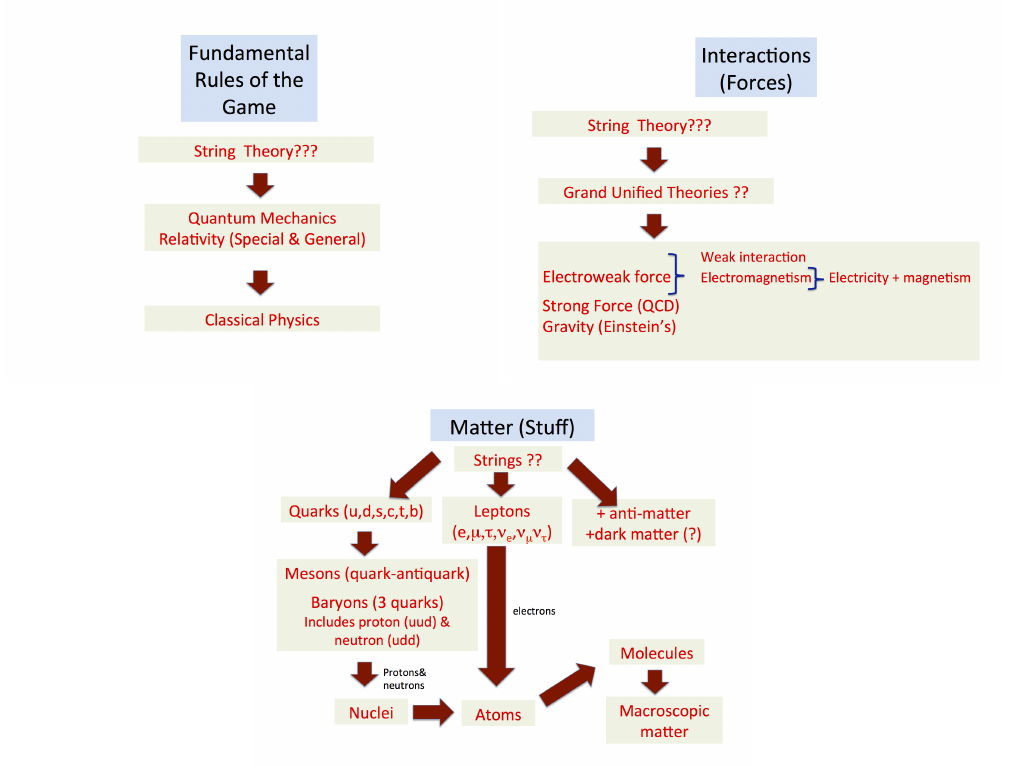
Figure 1: A highly incomplete and cartoon-like overview of the understanding of fundamental physics circa